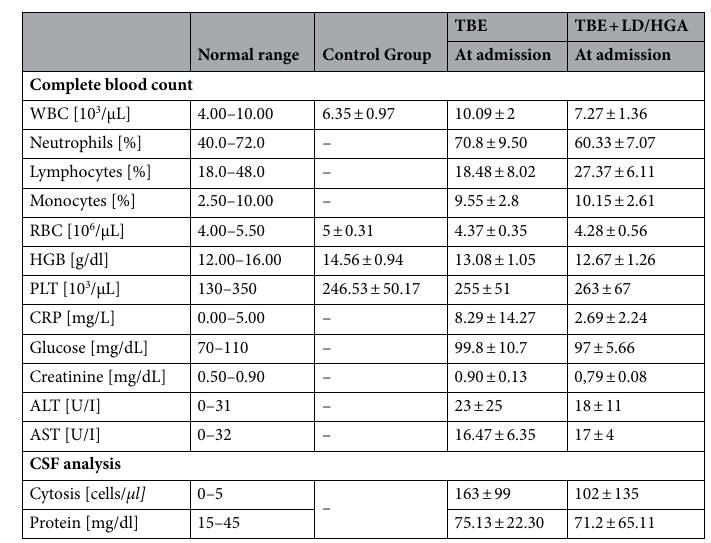
Table 2. Comparison of laboratory data of patients with TBE and co-infections (TBE + LD) compared to healthy subjects. Values are means ±